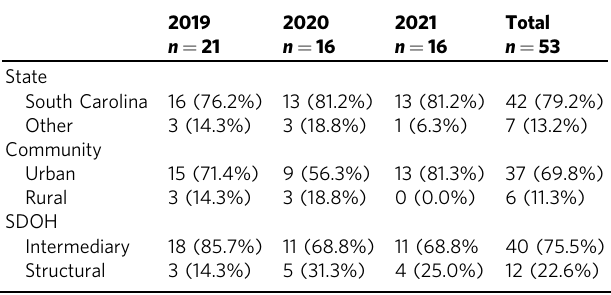
Table 1 Student Photo Essay Characteristics, n = 53 1 .